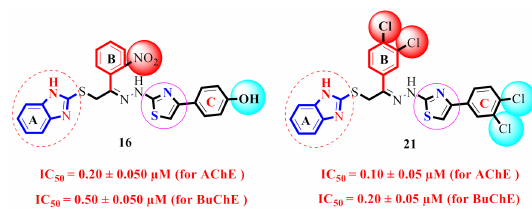
Figure 5. SAR study of the most active